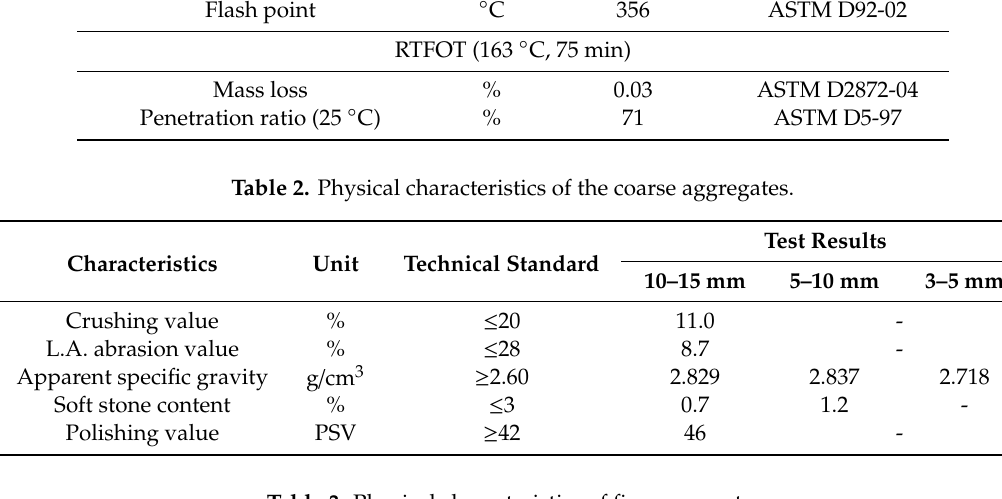
Table 3. Physical characteristics of fine aggregate.